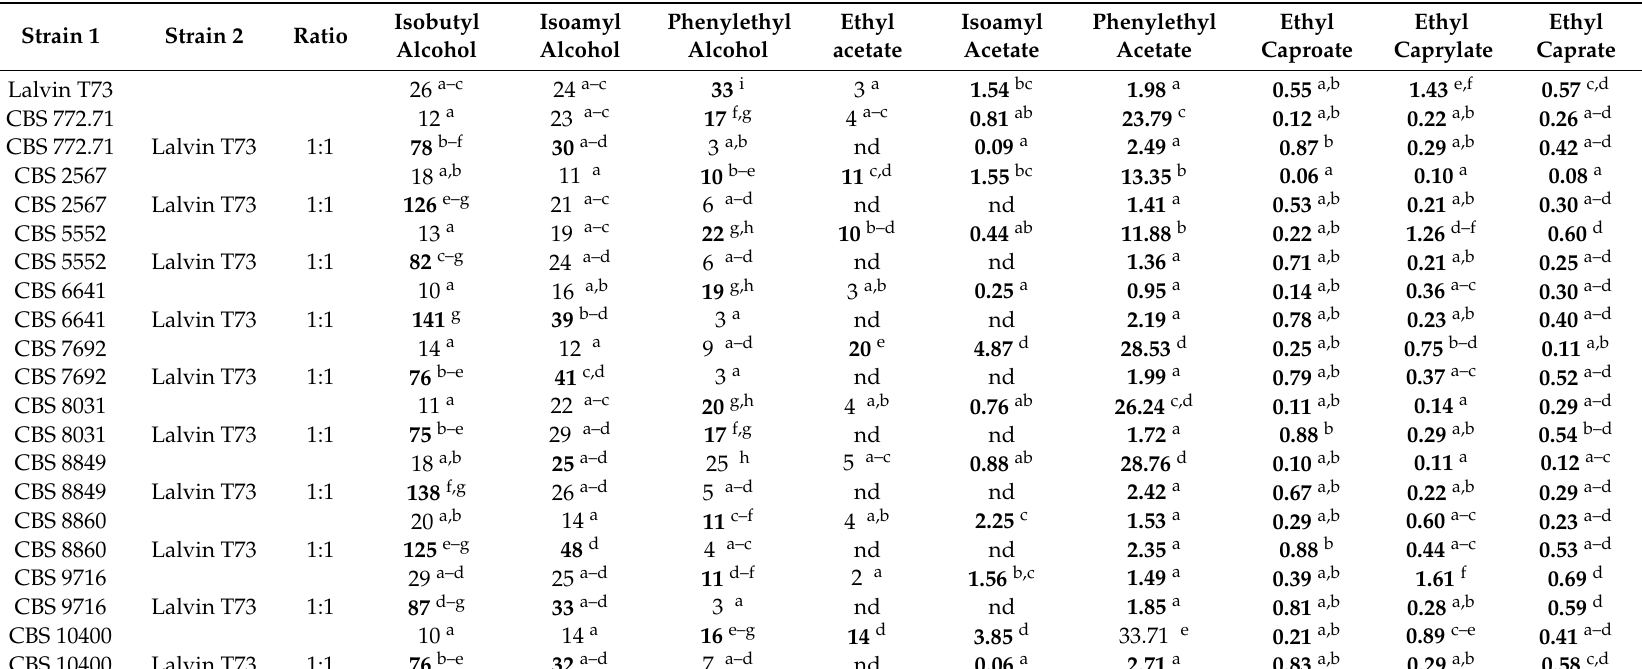
Table 4. Aroma compounds (mg / L) in the resulting